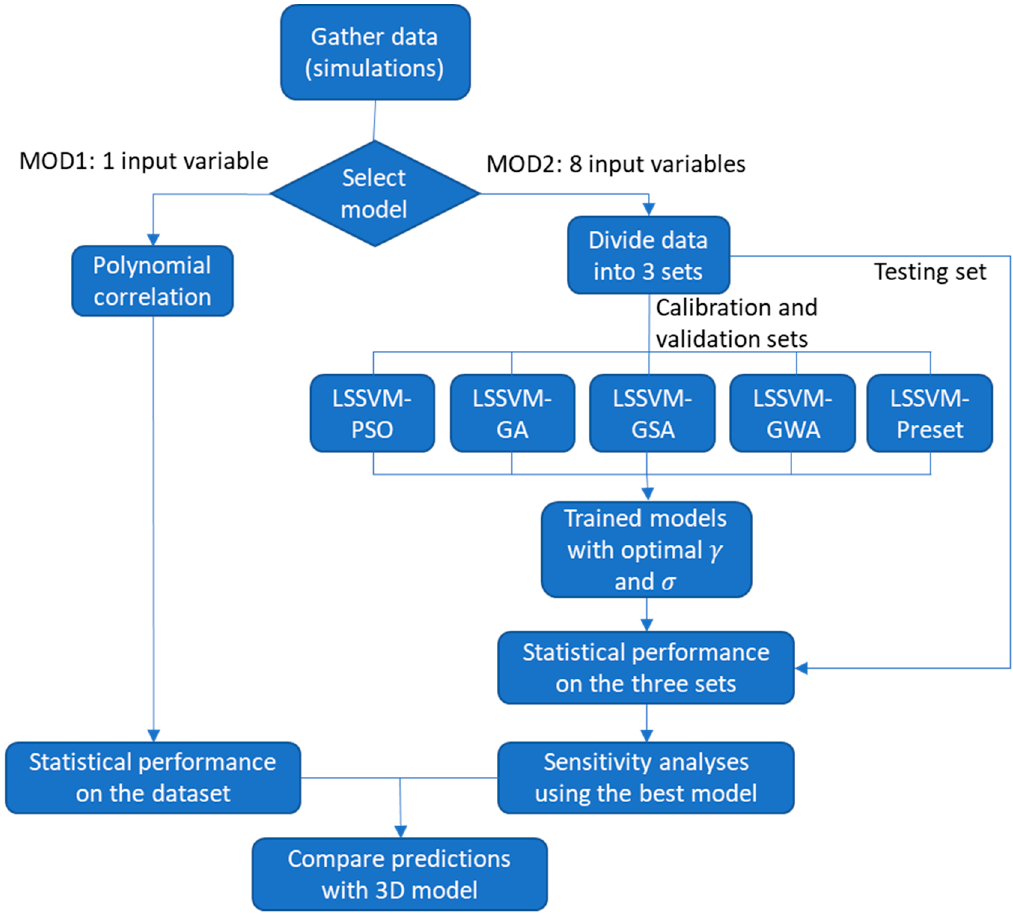
Figure 2. Workflow demonstrating the development, assessment and application of the models.